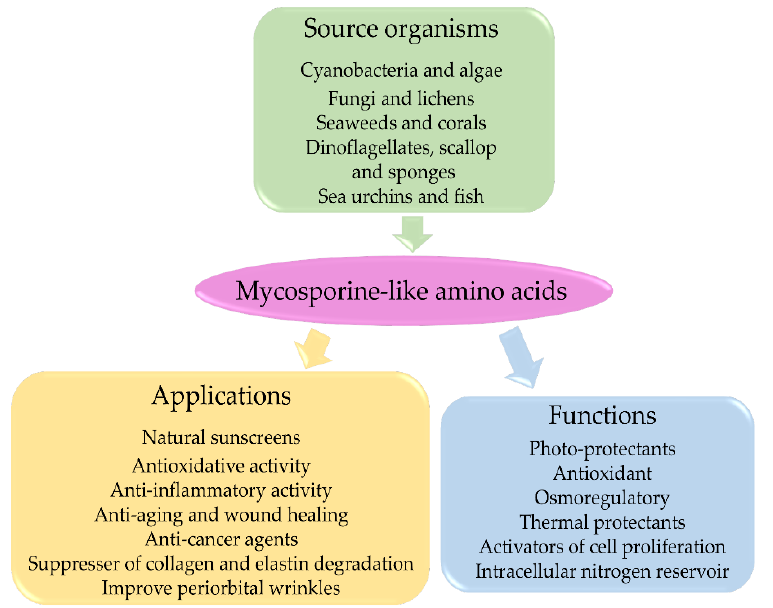
Figure 4. A scheme to represent MAA-producing organisms, biological functions of MAAs and their cosmetic